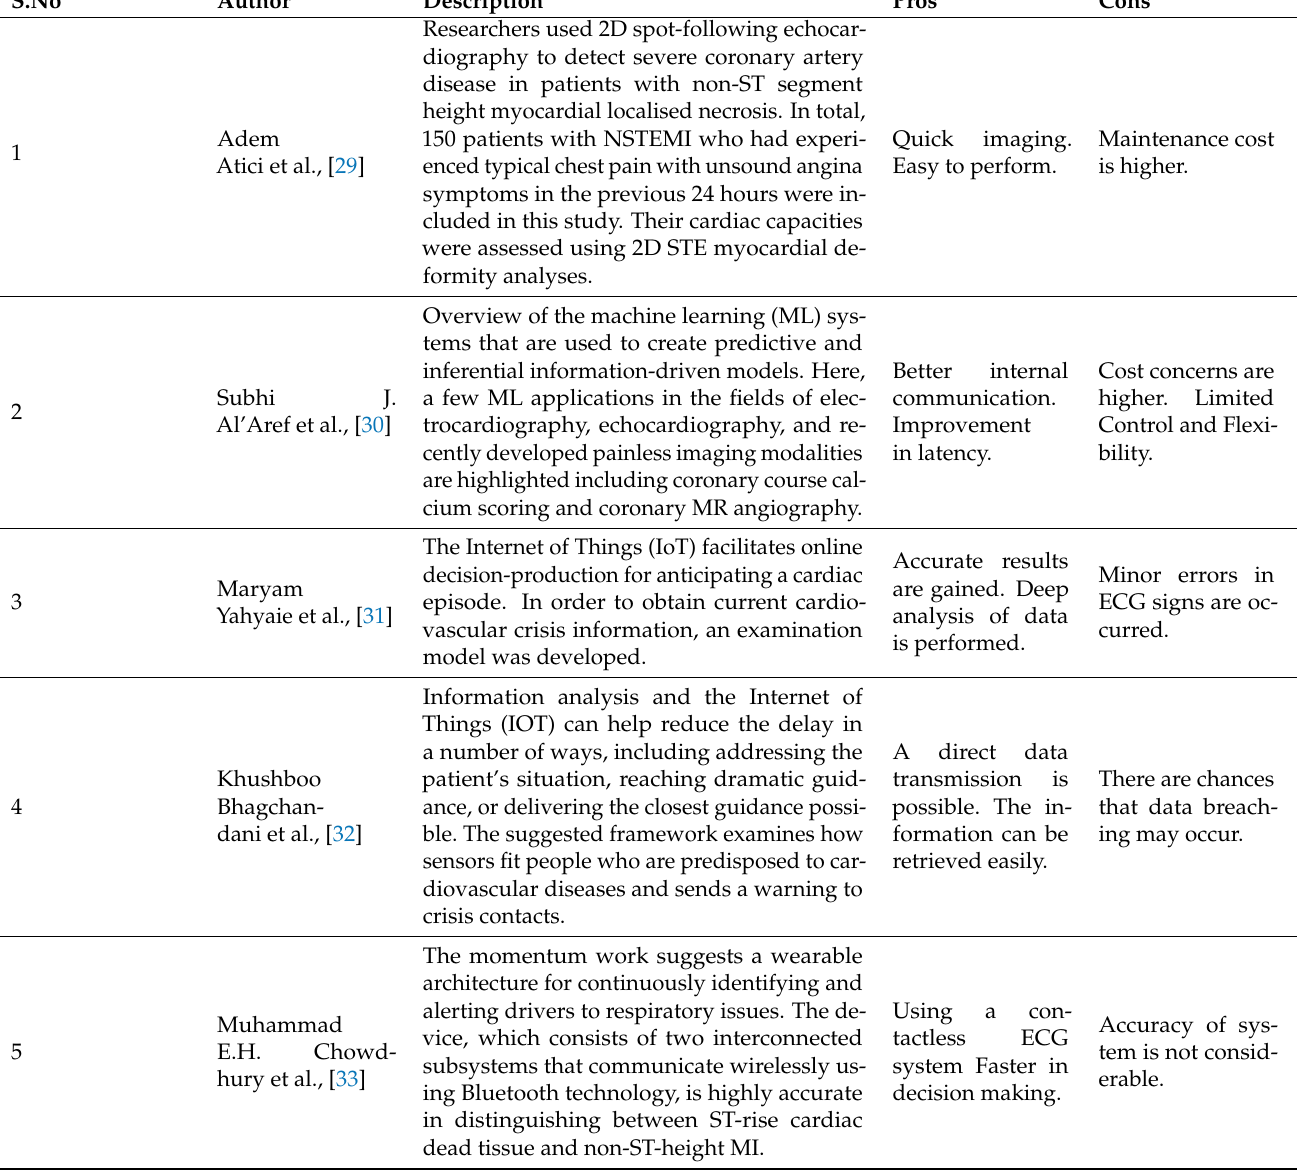
Table 2. Issues in existing